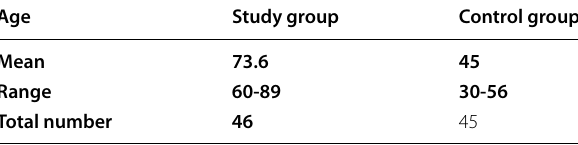
Table 1 Age distribution in the study and control groups Age